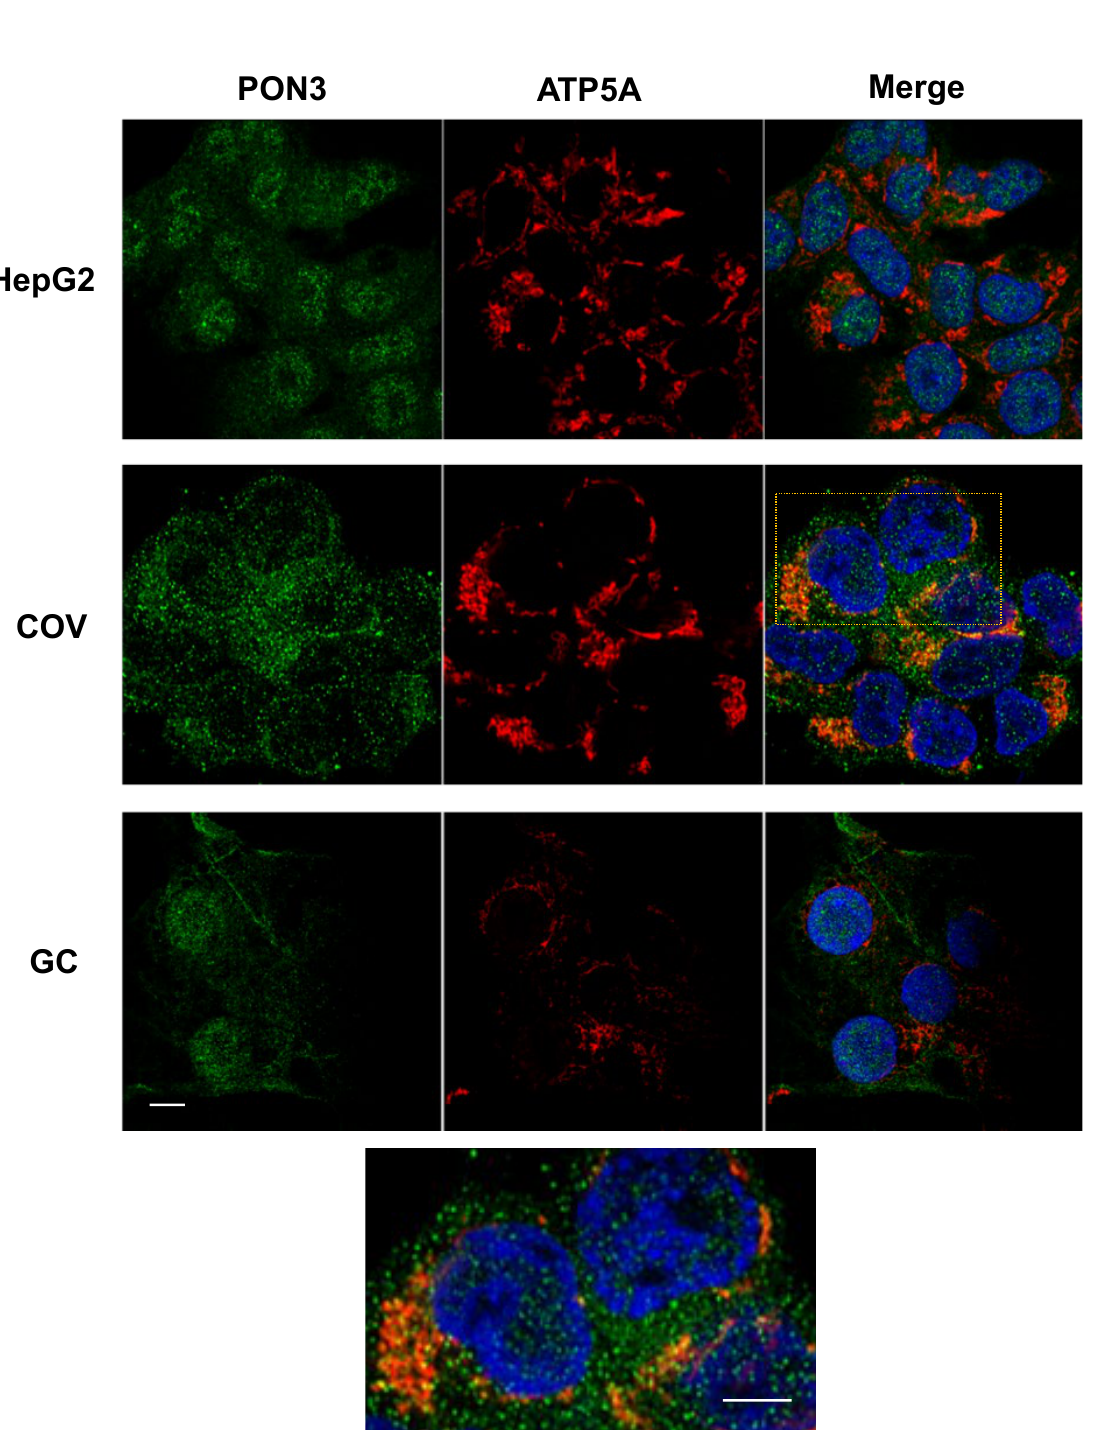
Figure 3. Intracellular distribution of ( A ) PON1, ( B ) PON2, and ( C ) PON3 in HepG2, COV434 (COV), and granulosa cells (GC). PON proteins appear in green and mitochondria in red. The nuclei were stained with DAPI (blue). Cells were examined by confocal microscopy. The white scale bar corresponds to 5 µ m. ( B , C ) Partial magnification of the areas from HepG2, COV434, and HepG2 indicated in the orange boxes is shown.